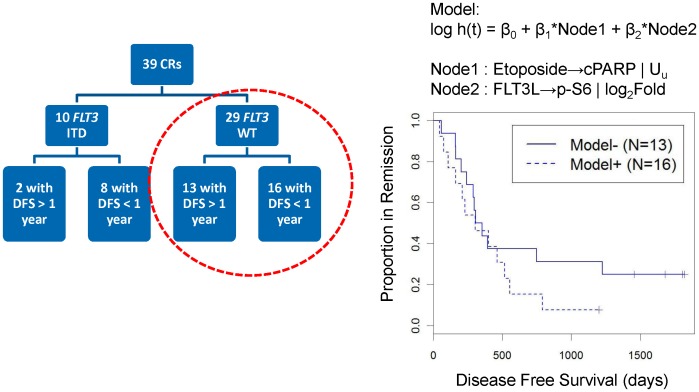
Multivariate model in FLT3 WT AML donors using combination of SCNP nodes: association with DFS.Association of SCNP readouts from apoptosis (Etoposide→cPARP | Uu) and proliferation (FLT3L→p-S6 | Log2Fold) pathways with DFS in a multivariate model among the patients with AML and FLT3 WT disease (n = 29).